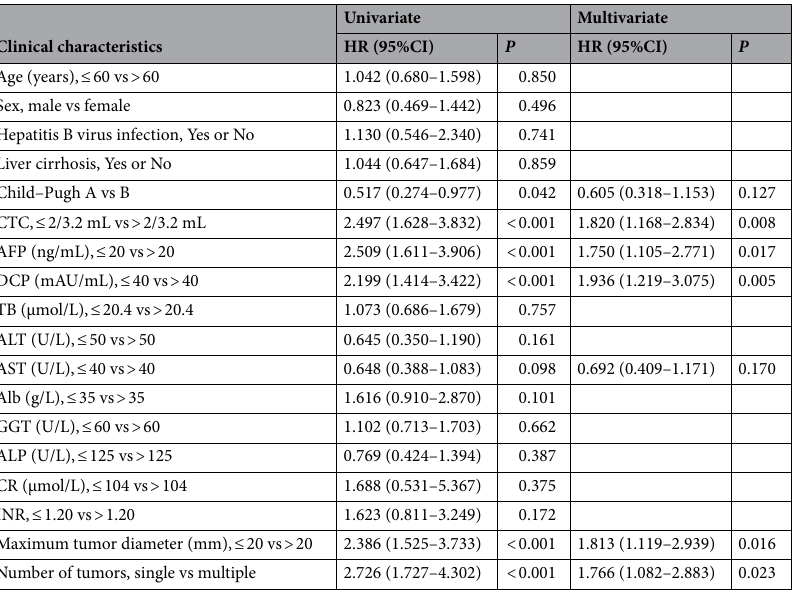
Table 3. Univariate and multivariate analysis of Cox regression model for recurrence of HCC after RFA. HCC, Hepatocellular carcinoma; RFA, Radiofrequency ablation; CTC, Circulating tumor cell; AFP, Alpha- fetoprotein; DCP, Des-γ-carboxy prothrombin; TB, Total bilirubin; ALT, Alanine aminotransferase; AST, Aspartate aminotransferase; Alb, Albumin; GGT, Gamma-glutamyltransferase; ALP, Alkaline phosphatase; CR, Creatinine; INR, International normalized ratio; HR, Hazard ratio; Cl, Confidence